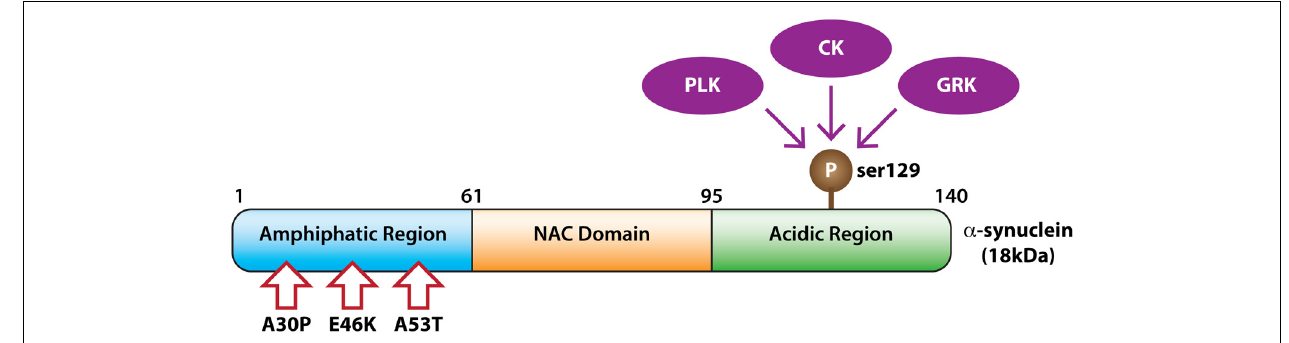
FIGURE 1 | Kinases phosphorylating α -synuclein. The domain structure of α -synuclein showing phosphorylation at serine 129 by members of the polo-like kinase (PLK), casein kinase (CK), and G protein coupled receptor kinase (GRK) families. Pathogenic α -synuclein missense mutations are indicated with